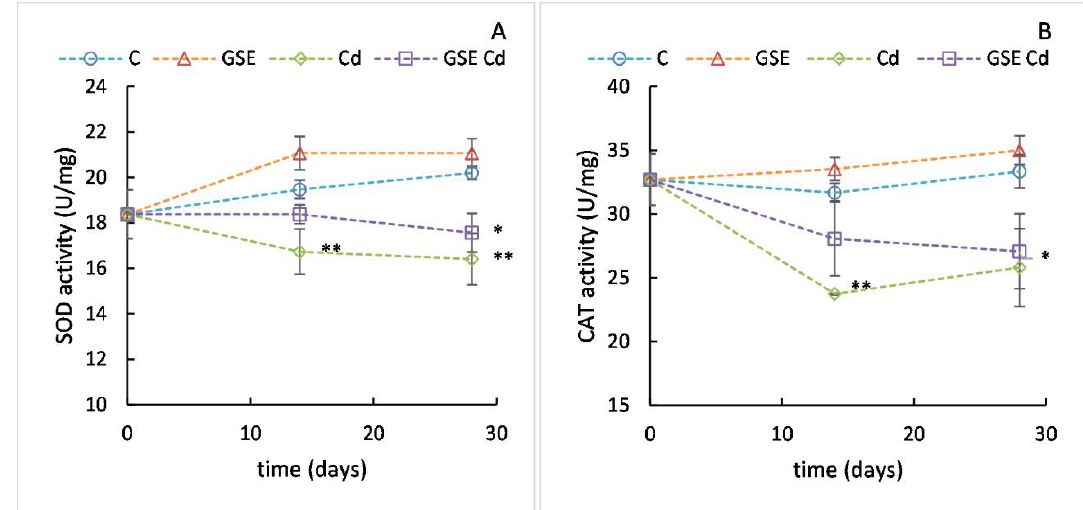
Figure 5. SOD ( A ) and CAT ( B ) activity values in the liver for the control variant (blue line with circles), the variant with GSE addition (orange line with triangles), the variant with Cd addition (green line with diamonds), and the variant with both GSE and Cd addition (violet line with squares) on days 0, 14, and 28 of monitoring. Data are presented as means ± sd from three replicates and expressed in U/mg of the protein. Data were analyzed by one-way ANOVA (each time point separately) and differences from control are marked: * indicates p ≤ 0.05, ** indicates p ≤